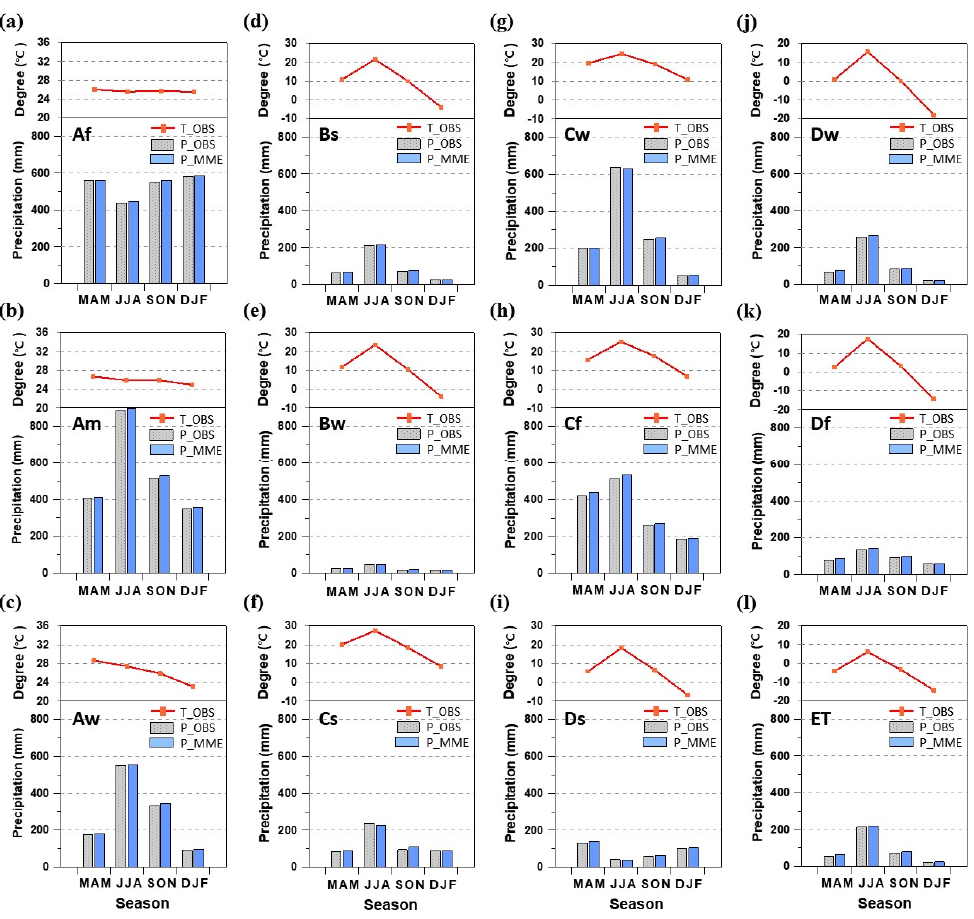
Figure 3. ( a – l ) Seasonal mean precipitation (mm) and temperature (°C) for individual 12 climate zone based on the observational and reanalysis data (OBS) datasets and the multimodel ensemble (MME) of five bias-corrected GCMs.